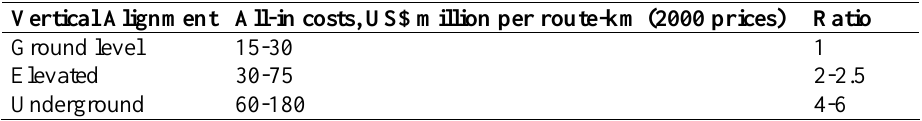
Elevated 30-75 2-2.5 Underground 60-180 4-6 Source: Halcrow Fox